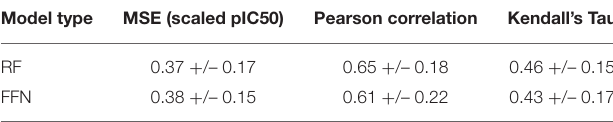
TABLE 2 | Performance metrics averaged across individual UniProt